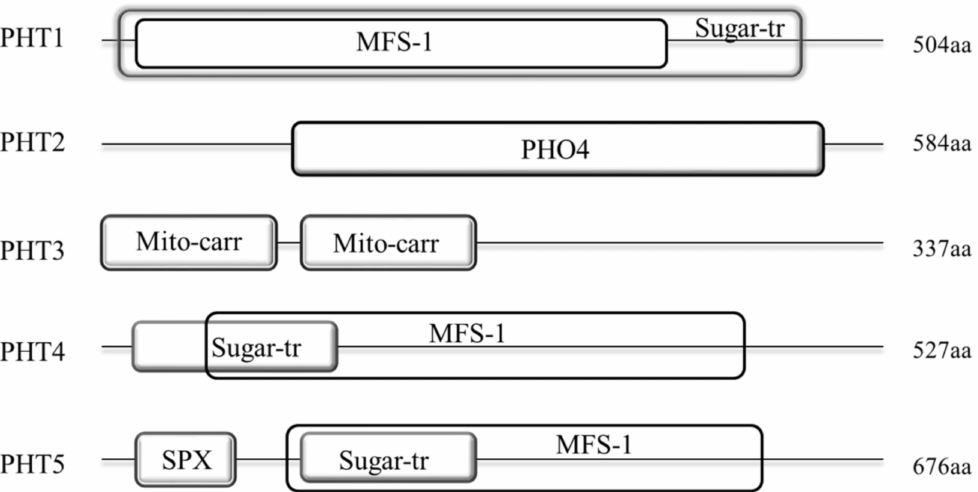
Figure 3. Architecture of conserved protein domains in the five PHT families in B. napus . The conserved domains by Simple modular architecture research tool (SMART) were represented by di ff erent size boxes. The average protein length of each family is indicated on the